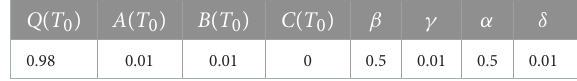
TABLE 6 Baseline setting for simulation.